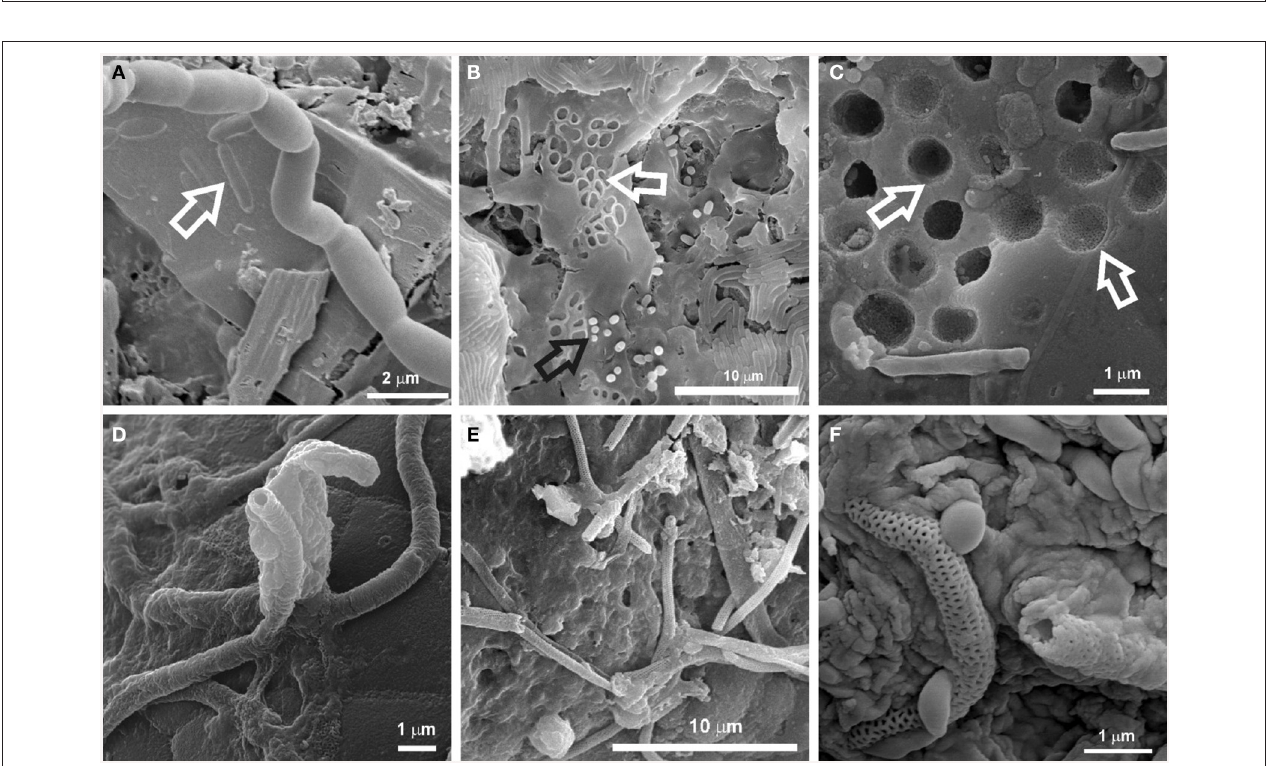
FIGURE 3 | SEM images of biosignatures found associated with microbial mats in Azorean, Canadian, Canarian, and Hawaiian volcanic caves. (A) Cell-shaped etched pits on mineral grain (arrow) from Helmcken Falls Cave (British Columbia Canada); (B) Cell imprints (white arrow) and rods on EPS matrix from a white microbial mat in Gruta da Terra Mole (Terceira Island, Azores, Portugal); (C) Microborings produced by euendolithic cells on silicified mineral grains from Ana Heva cave in Easter Island, Chile (adapted from Miller et al., 2014); (D) Tubular mineralized sheaths embedded in EPS found on black deposits from Cueva del Llano de los Caños cave(La Palma Island, Spain). (E) Reticulated filaments found in white microbial mats in the Kula Kai Caverns of the Kipuka Kanohina Cave Preserve (Hawai`i, U.S.A.); (F) Close-up view of mineral encrusted filaments with reticulated ornamentation associated with white microbial mats on ooze-like deposits from Fuente de la Canaria cave (La Palma Island,